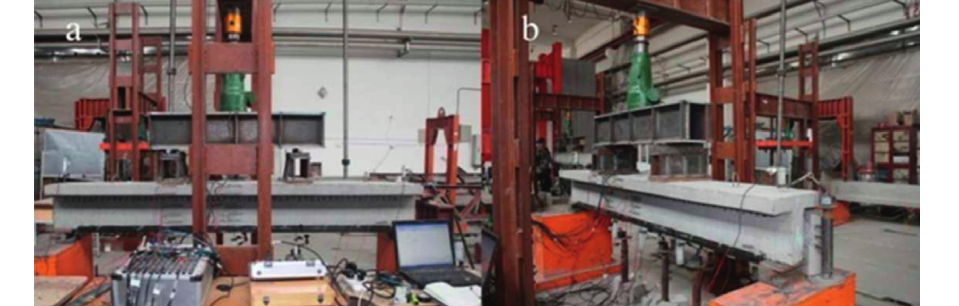
Figure 9: Loading process.